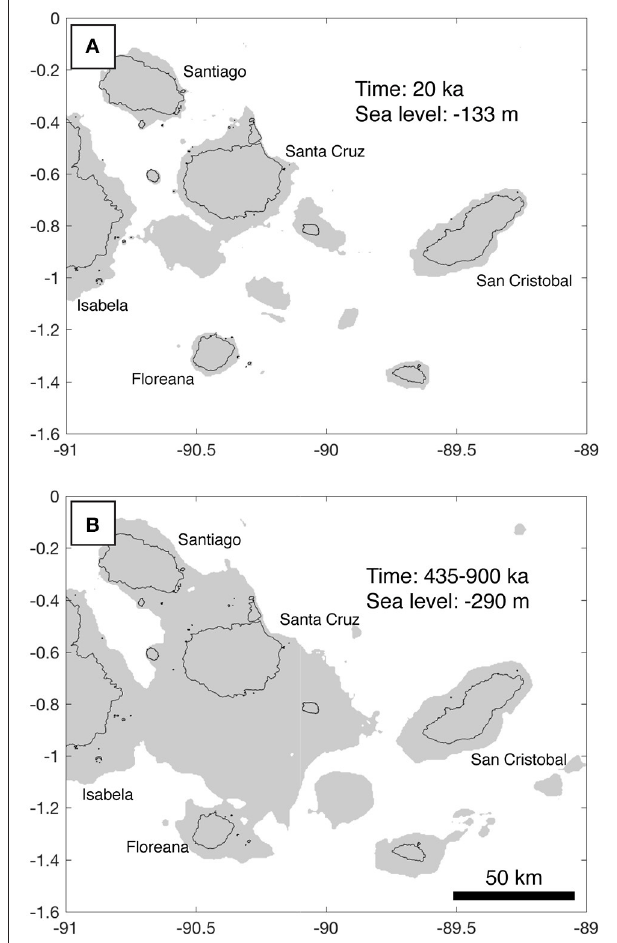
FIGURE 13 | (A) Map of the central Galápagos Archipelago during the last glacial maximum assuming a subsidence rate of 0.2 m/ka. Black lines show modern shorelines. Gray area shows exposed areas adjusted for the combined sea level change and subsidence. (B) Map of the central Galápagos Archipelago that was emerged based on the max depth that rounded cobbles on erosional terraces were observed (290m; Figure 8B ). Black lines show modern shorelines. Gray area shows exposed areas adjusted for the combined sea level change and subsidence. Based on our best-fit subsidence rates of 0.2 to 0.4 m/ka this paleo-topography was first possible between 435 and 900